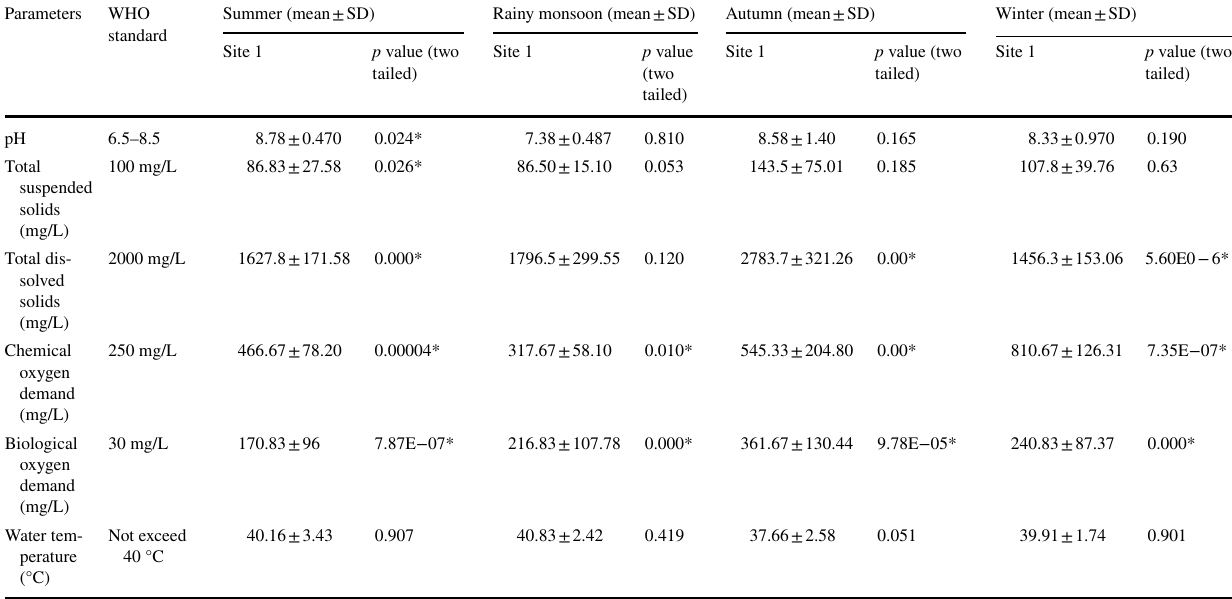
Table 2 Seasonal fluctuations in physicochemical parameters at Site 1 from June 2014 to May 2015